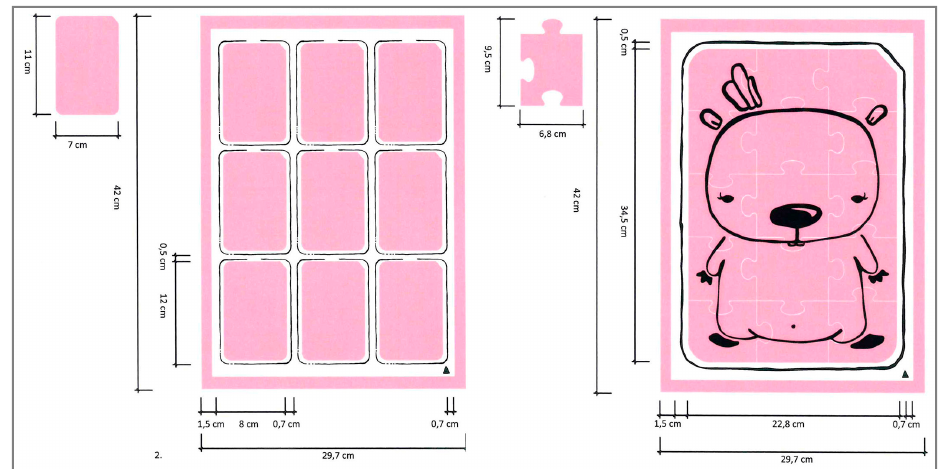
Figure 5. On the left, one of the two designs for the memory game. On the right, dimensions and complete drawing of the puzzle. The creation of a single big box allows users not to go out of the game space. The number and size of the pieces take into account the perceptible size of the touch, and the number of information that the child can store and his age.